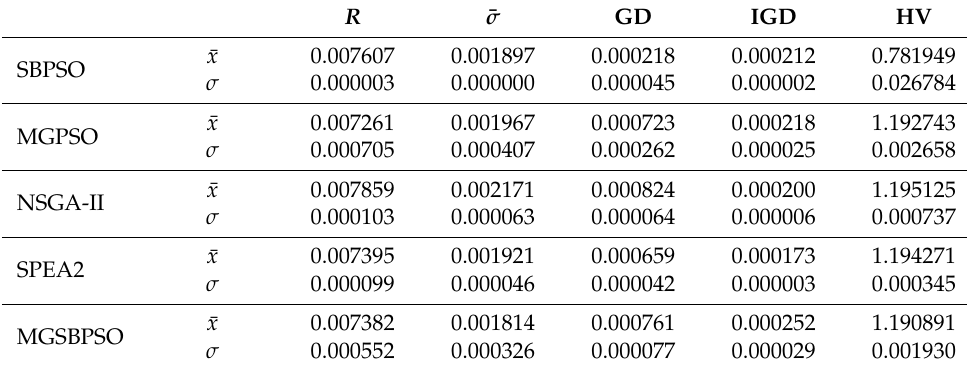
Table 5. Hang Seng results for each performance